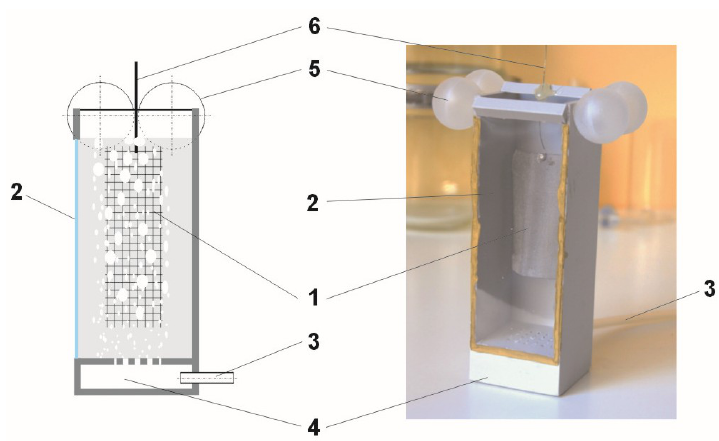
Figure 1. Cathode with casing made of high-impact polystyrene (HIPS): ( a ) cross section (schematic) 1: cathode with Ni–Co catalyst, 2: proton exchange membrane (PEM), 3: air supply, 4: air chamber, 5: float, 6: electrical connection; ( b ) housing with cathode and PEM.